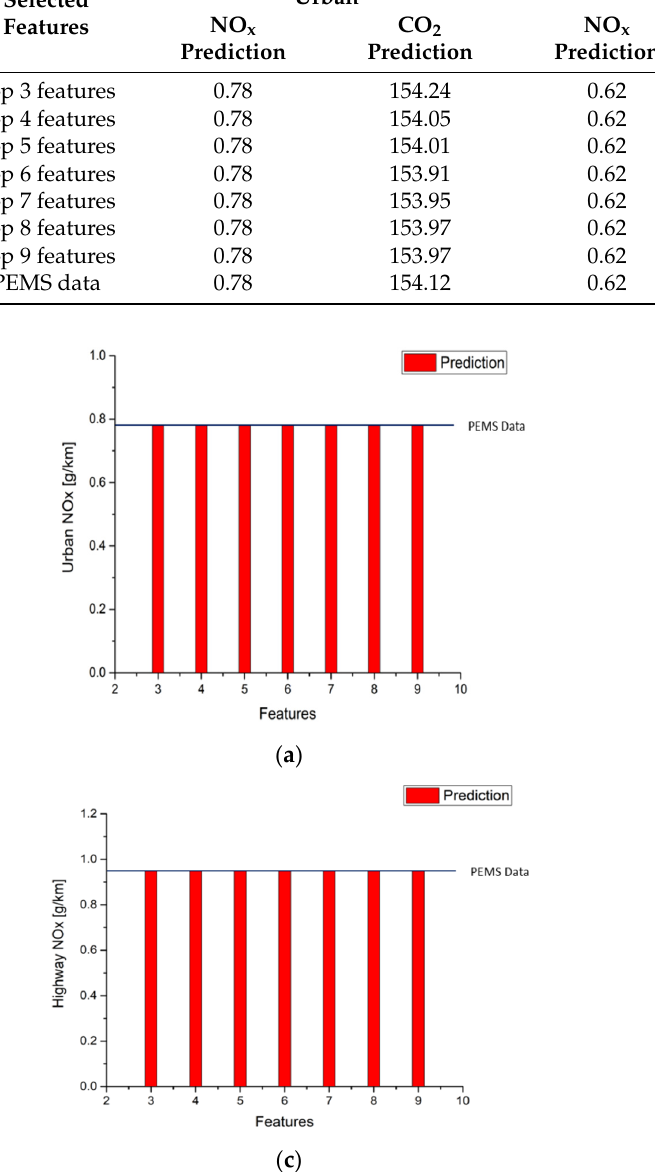
Figure 13. Results of NO x emission factor predictions ( a ) Urban; ( b ) Suburbs; ( c ) Highway.